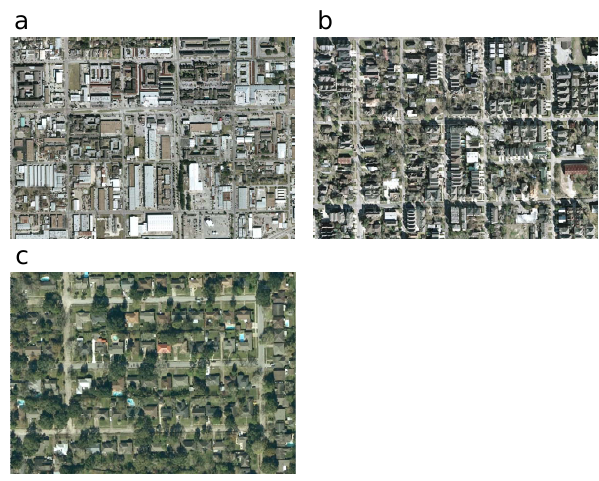
Fig. 3. Example satellite images of three different urban morphol- ogy representing (a) commercial/industrial area, (b) high-density residential area, and (c) low-density residential area in Houston (Source: Google